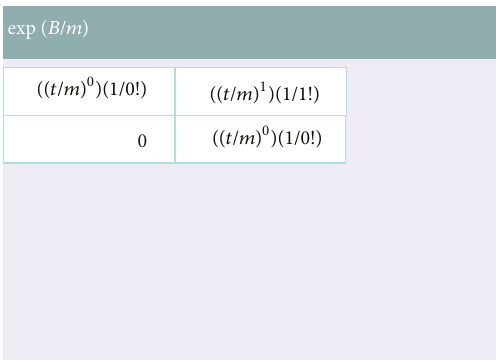
Figure 5: Matrix exp (𝐵𝑡/𝑚) .